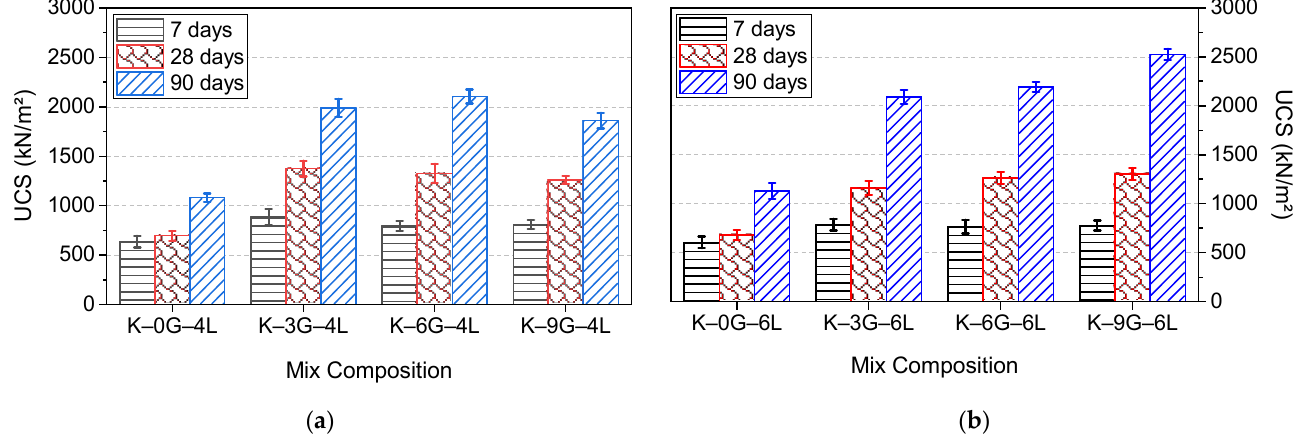
Figure 5. UCS development of kaolin specimens made with different gypsum concentrations (0, 3, 6, and 9 wt%) and stabilised with two different lime contents: ( a ) 4 wt% and ( b ) 6 wt%. By comparing both 4L- and 6L-based series, it was evident that a mix composition of K–6G–4L (G/L = 1.5) demonstrated the highest 90-day UCS of 2105 kN/m 2 at 4 wt% lime (4L), while K–6L–9G (G/L = 1.5) yielded the highest 90-day UCS of 2524 kN/m 2 at 6 wt% lime (6L). This, therefore, provides convincing evidence of a consistent correlation between the UCS and G/L ratio. In the light of this information, it can be eventually summarised that the UCS is proportional to both lime and gypsum concentrations, of which a G/L ratio of 1.5 yields the highest degree of strength.